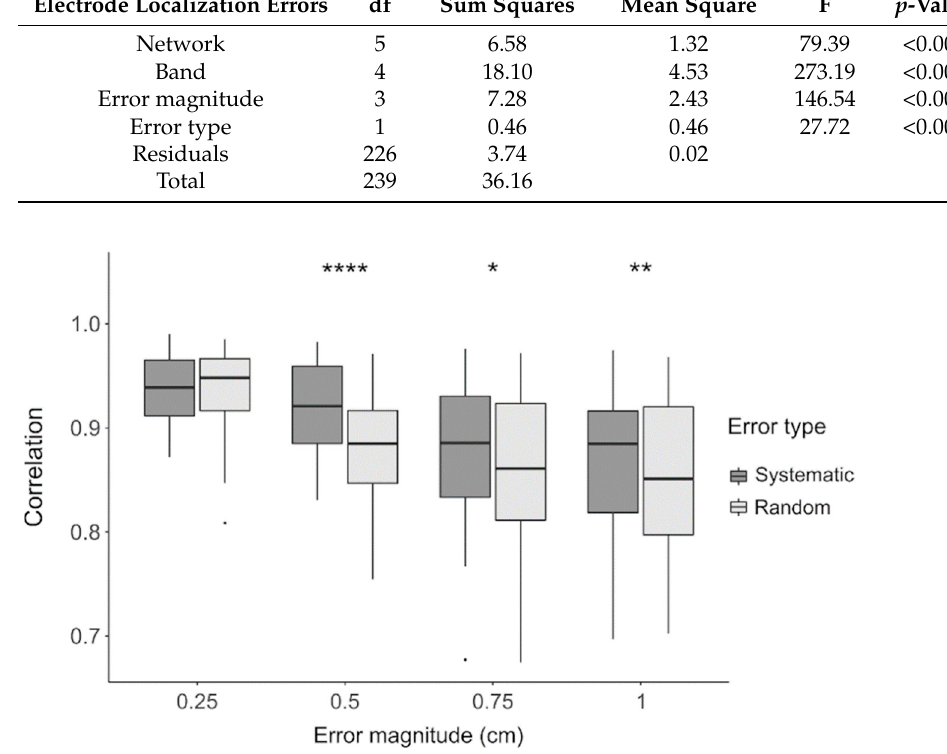
Figure 6. Correlation between the reference connectivity matrices and those obtained when intro- ducing electrode localization errors. For each error, magnitude is tested in the range 0.25 to 1 cm, and distinction is made between systematic (dark grey) and random (light grey) errors. Black dots represent the outliers. The asterisks define the significance level of the two-tailed Wilcoxon signed- rank paired test between error types, for each error magnitude: * for p < 0.05, ** for p < 0.01, **** for p < 0.0001.